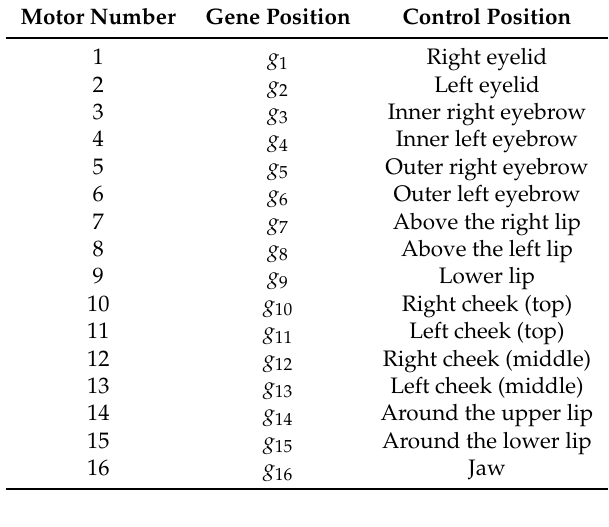
Table 1. Relationships between face control positions and genes.